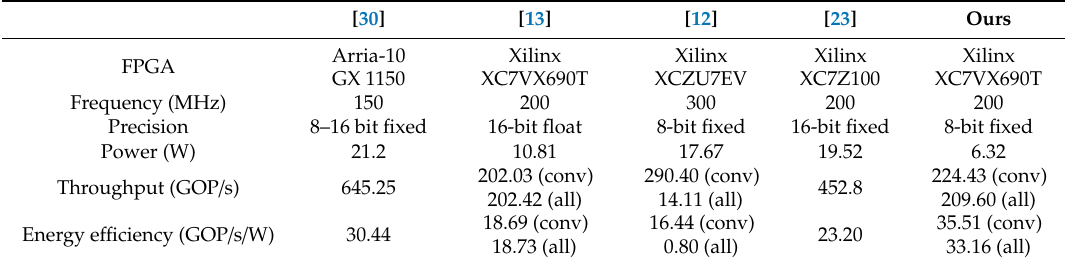
Table 5. Comparisons with previous